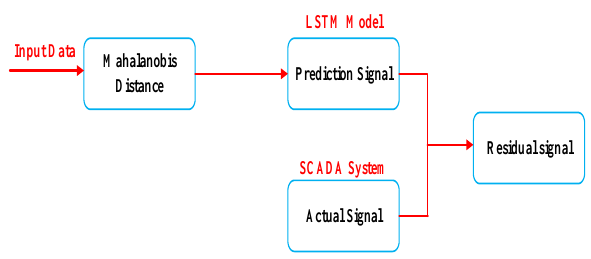
Figure 3. The framework of the proposed condition monitoring method.